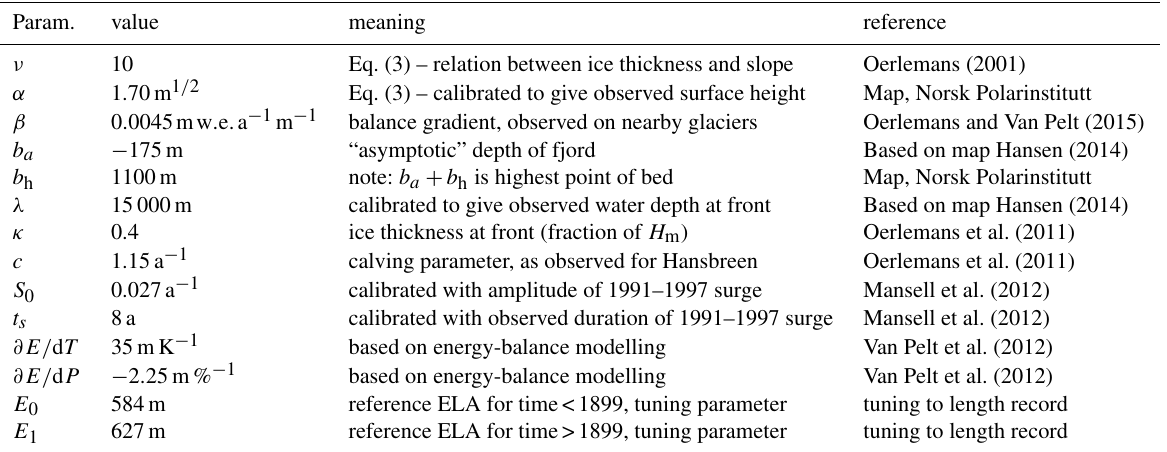
Table 1. Overview of model parameters with corresponding references for more information.